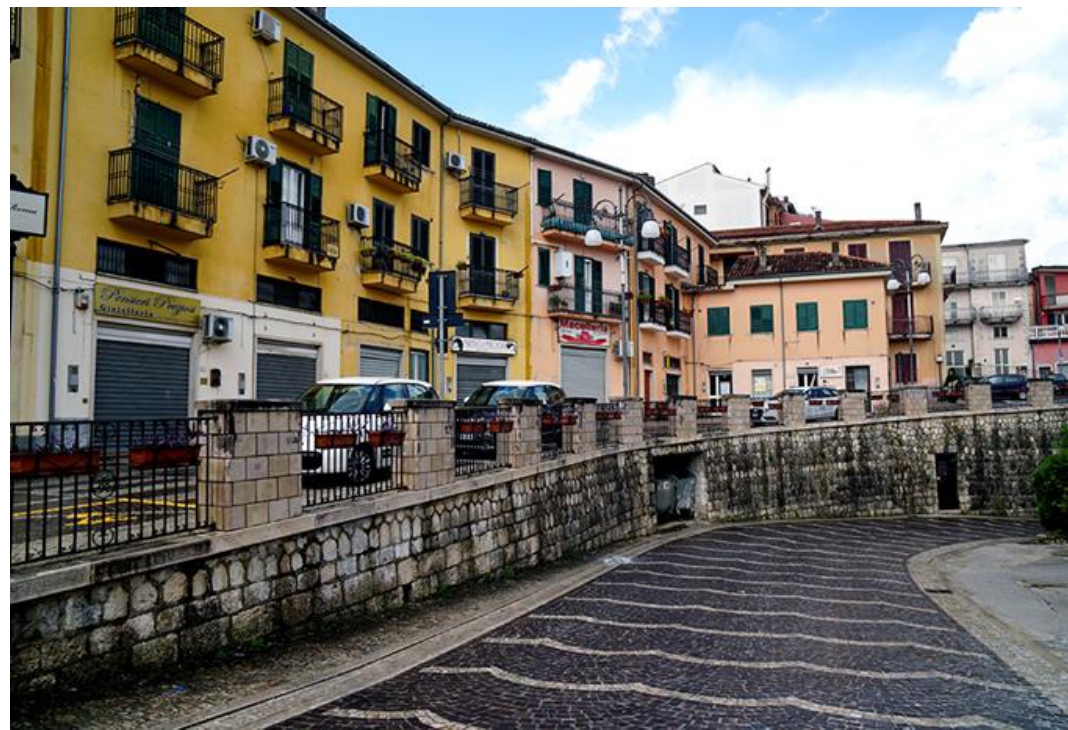
Figure 45. Caposele: the historical center with the new buildings reconstructed taking into account the original urban design (photos by [35,36]).